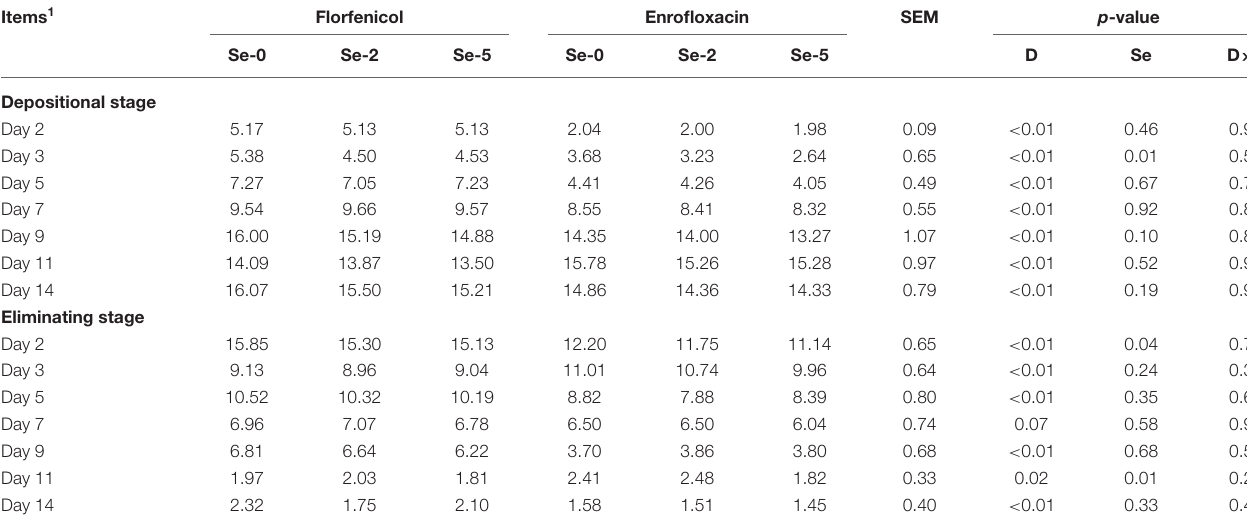
TABLE 7 | Effects of dietary organic selenium on residue of drugs in breast muscle of laying hens. Items 1